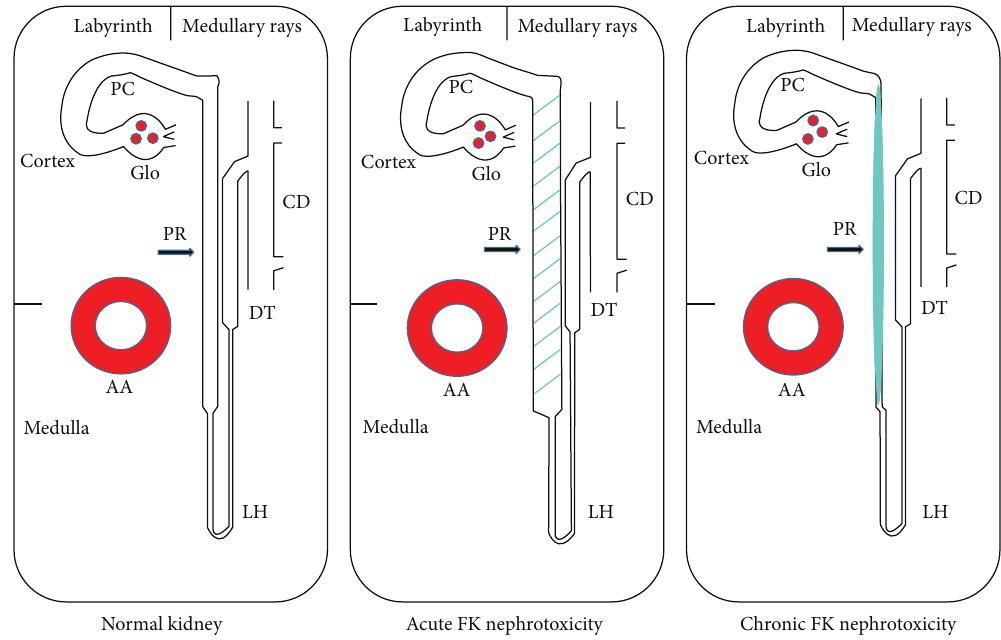
Figure2:Diagrammaticchangesinparsrecta(PR)innormalkidney(leftpanel),inkidneywithacutetacrolimus(FK)nephrotoxicity(middle panel) and in kidney with chronic tacrolimus nephrotoxicity (right panel). In this simplified kidney diagram of normal kidney (left panel), the pars convoluta (PC) located in labyrinth of cortex is connected with pars recta (PR) in medullary rays and outer stripe of outer medulla. The latter is further connected with distal nephron tubules including loop of Henle (LH), distal tubules (DT), and collecting duct (CD). The arcuate artery (AA) is located at the cortical-medullary junction. During acute tacrolimus nephrotoxicity (middle panel), PR becomes dilated (dashed segment) that injury can be detected by positive KIM-1 staining. During chronic tacrolimus nephrotoxicity (right panel), the PR becomes atrophic with surrounding striped fibrosis (illustrated with solid bar) along the medullary